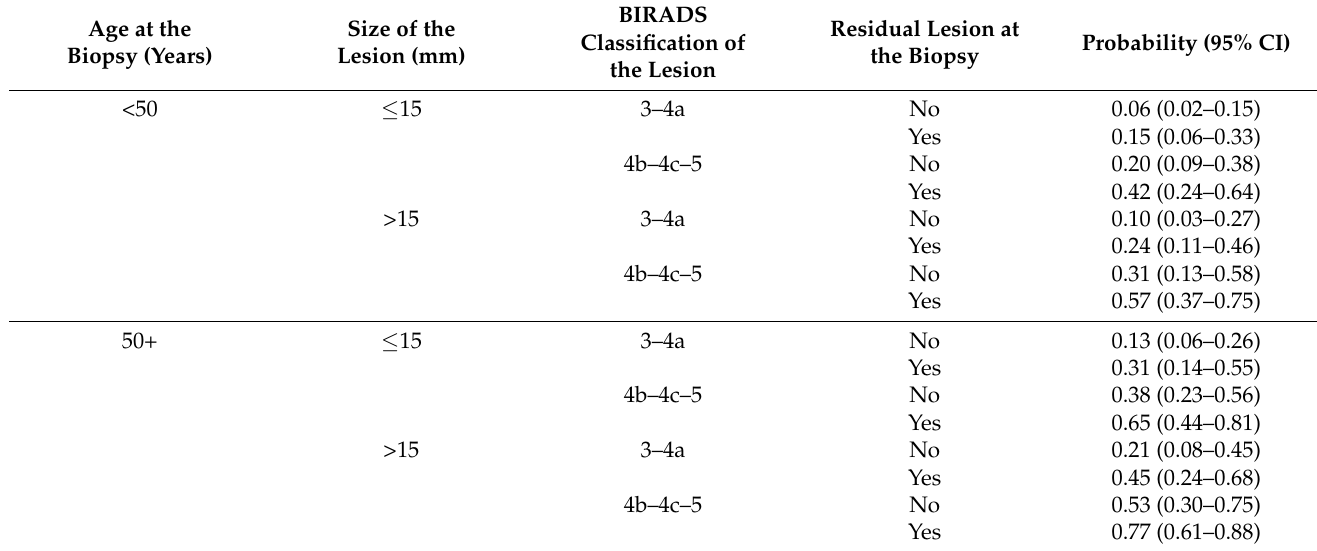
Table 4. Predicted probabilities of the upgrade from ADH to either DCIS or invasive disease, according to the multivariate logistic regression model.